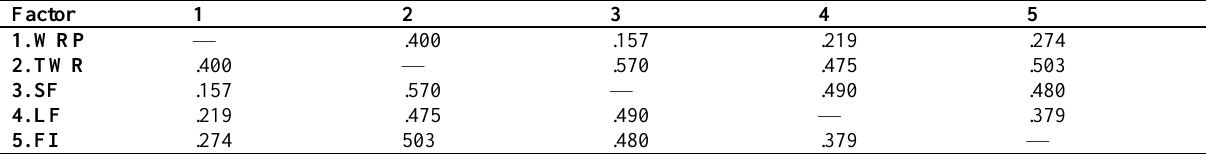
Table 2: Pearson Correlation for I-Deals and Work Role